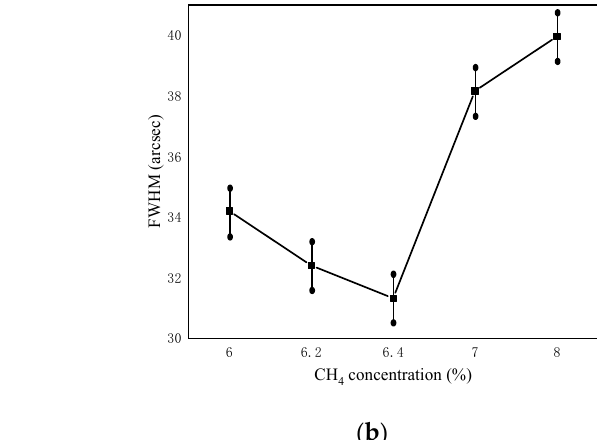
cally smooth surface. smooth surface.